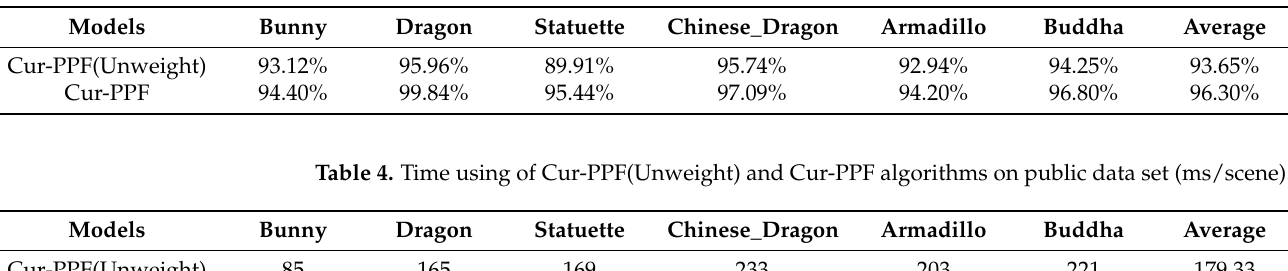
Table 3. The matching rate of Cur-PPF(Unweight) and Cur-PPF algorithms on public data set.